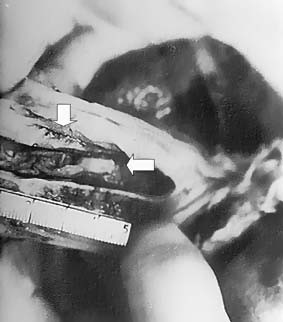
Tracheobronchial membranes at autopsy. Autopsy findings revealed numerous diphtheritic membrane formations (arrowheads) extended down into the larynx and further obstructing the distal tracheobronchial tree.